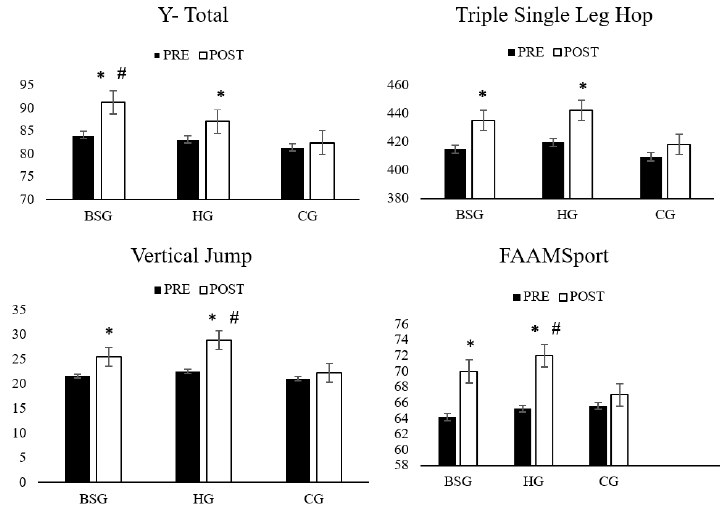
Figure 5. Pre to post test of Y- Total, Triple single leg hop, Vertical Jump and FAAMsport. * denotes difference between pre to post test ( p < 0.05). # denotes difference between BSG versus HG ( p < 0.05).